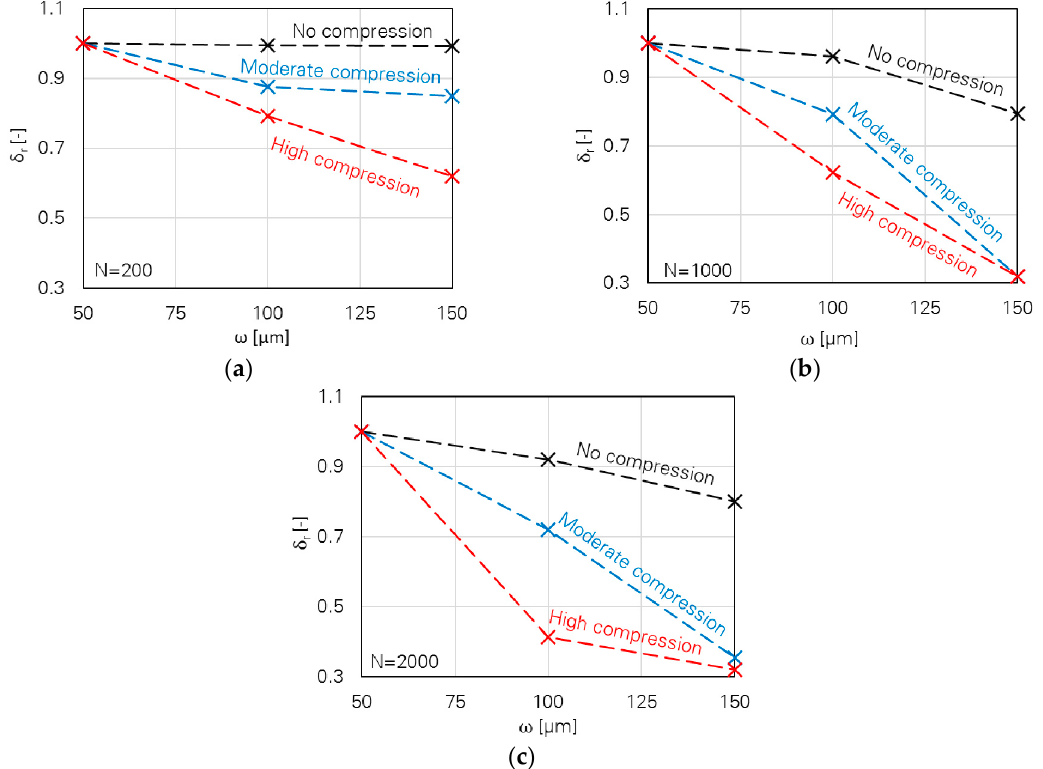
Figure 14. Degradation index ( δ r ) as a function of crack width ( ω ), cyclic compressive stress ( σ c ) on the fracture surface, and number of cycles (N): ( a ) N = 200, ( b ) N = 1000 and ( c ) N = 2000.